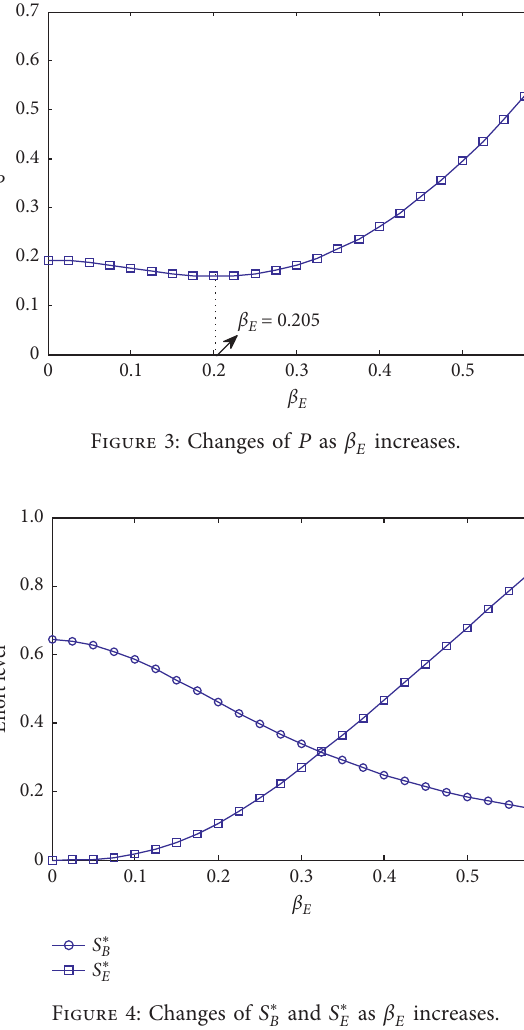
S ∗ B and E as β E increases.